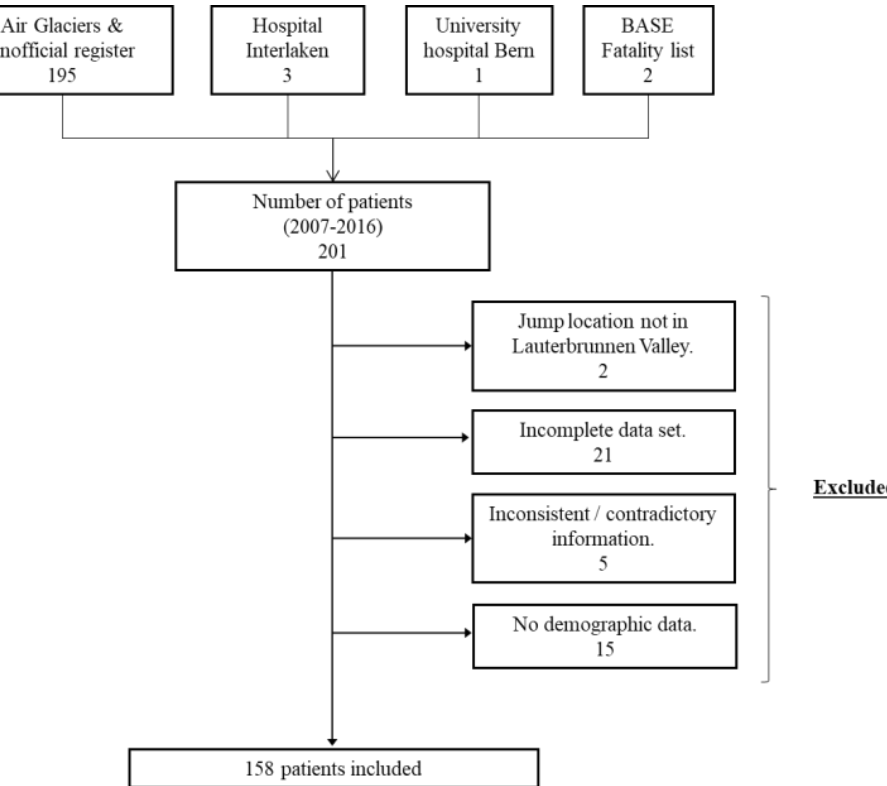
Figure 1. Study Figure 1. Study design.